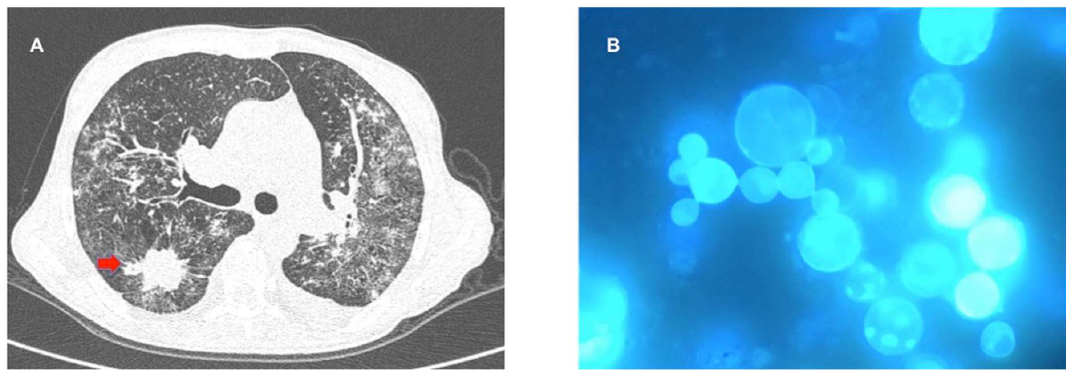
Figure 3. ( A ) Chest computed tomography scan showing spiculated nodule from adenocarcinoma (red arrow) and bilateral diffuse bronchoalveolar infiltrates from PCM. ( B ) Bronchoalveolar lavage with yeast cells with multiple daughter buds (Calcofluor white, 1000×). Figure A provided by Dr.